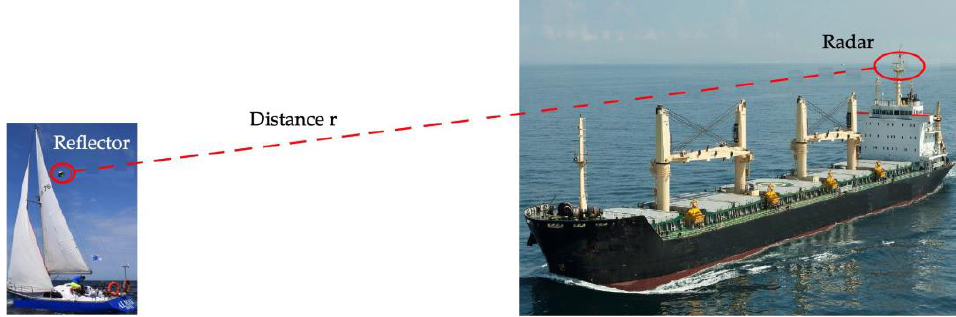
Figure 1. Detection of the small maritime target (yacht) reflector by the radar of a large